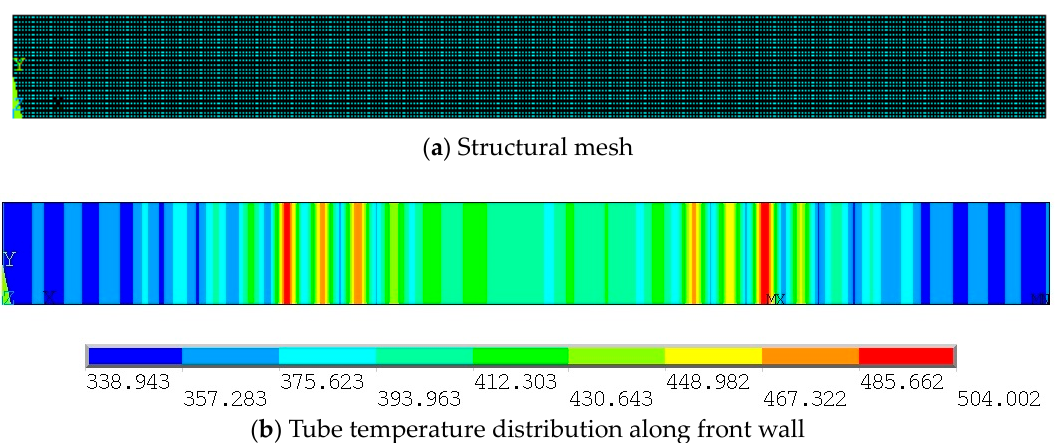
Figure 11. Front wall model and temperature boundary of the finite element.